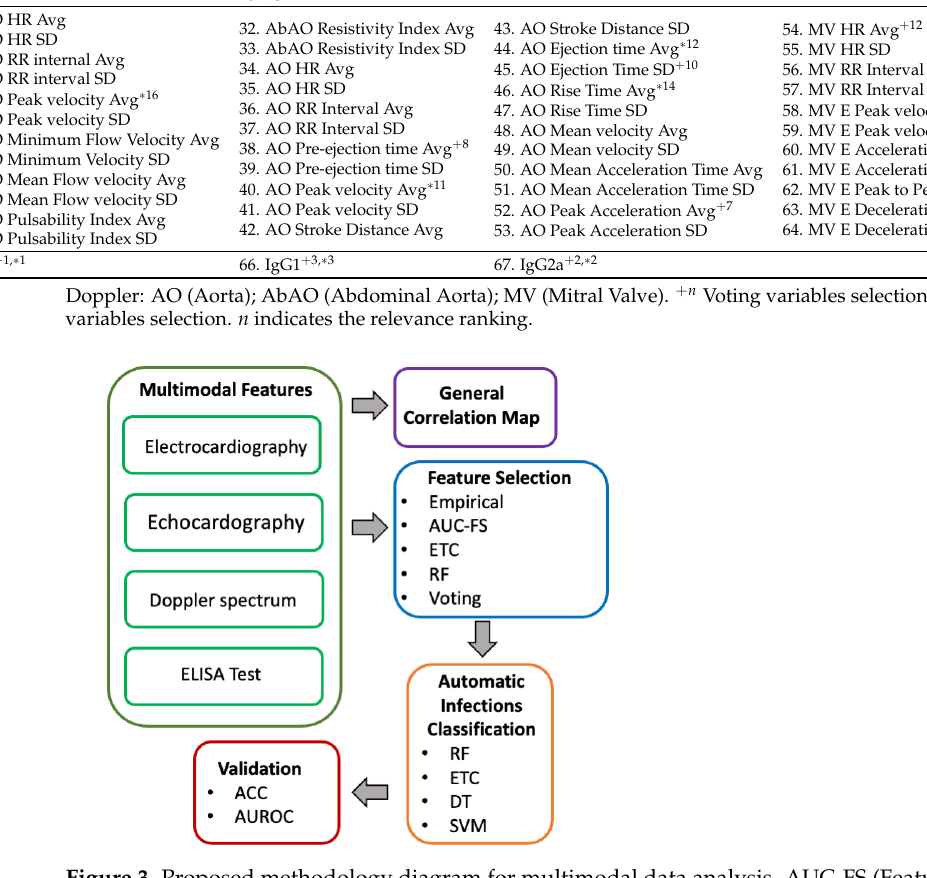
Figure 3. Proposed methodology diagram for multimodal data analysis. AUC-FS (Feature Selection by Area Under the Curve), ETC (Extremely Randomized Trees Classifier, RF (Random Forest), DT (Decision Tree), SVM (Support Vector Machine), ACC (Accuracy) and AUROC (Area Under the ROC Curve of the posterior